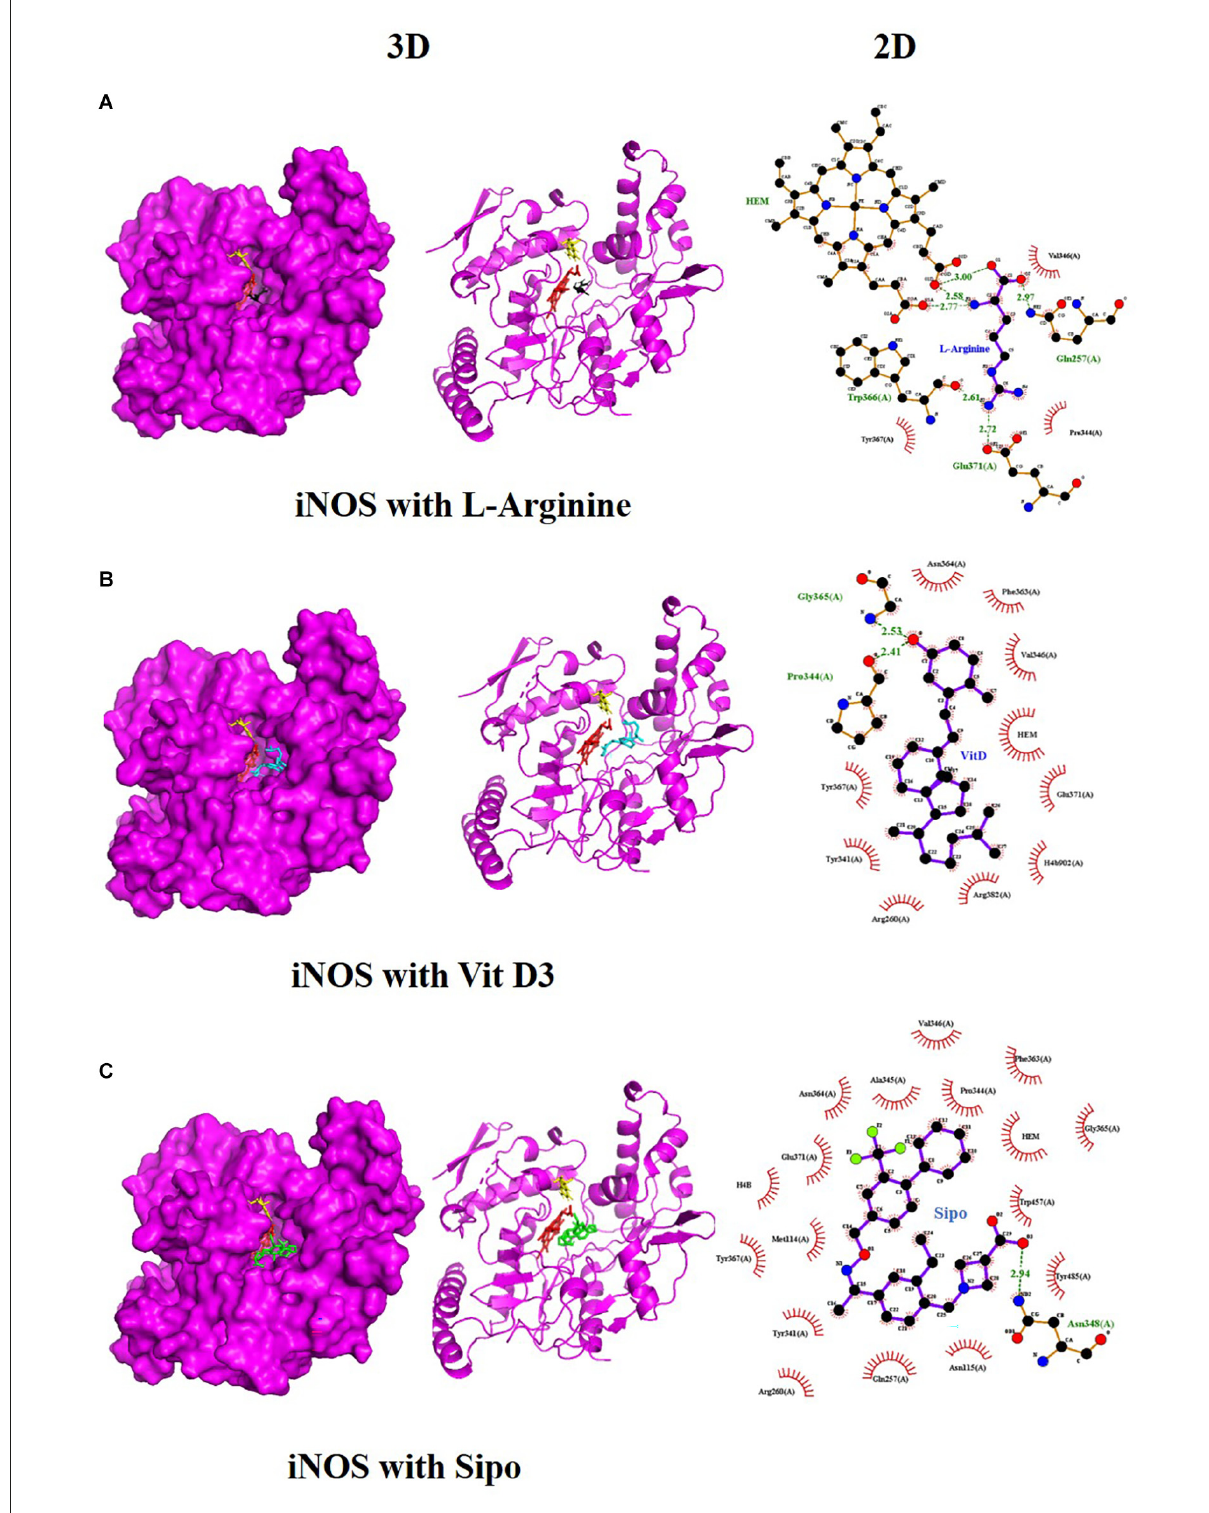
FIGURE9 Interaction between iNOS and (A) L-Arginine, (B) Vit D3, and (C) Sipo at the binding site, represented as 3D and 2D, respectively. Green spoked arcs represent hydrogen bonds, and brick red spoked arcs represent hydrophobic interactions. iNOS, inducible nitric oxide synthase; Vit D3, vitamin D3; Sipo,